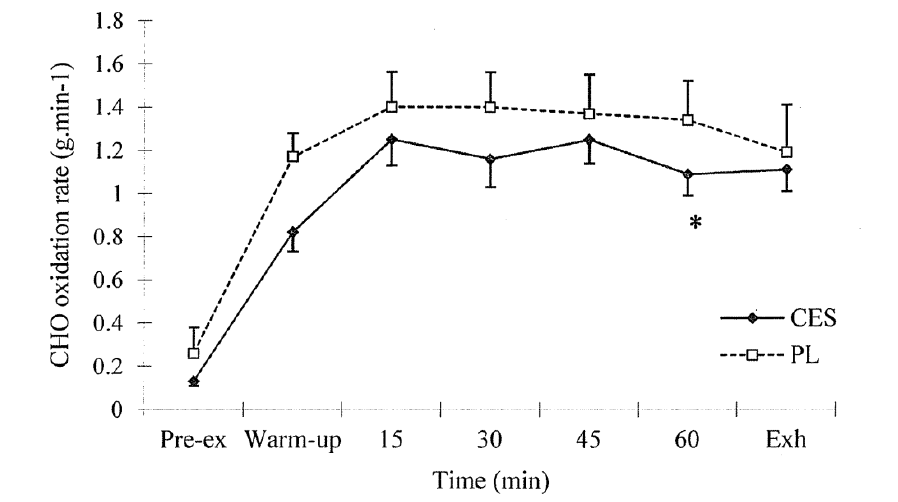
Figure 1. CHO oxidation rate (g·min −1 ) during treadmill running. Values (mean ± SEM) are for placebo (PL) and carbohydrate-electrolyte solution (CES) trials. * CES vs. PL, p <